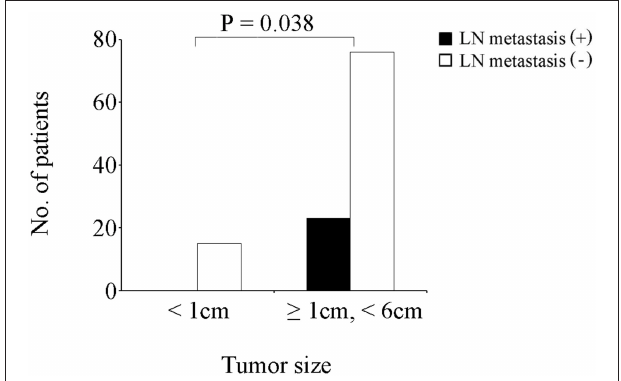
FIGURE 2 | Comparison of GBA patients receiving EC according to LN status and tumor size.